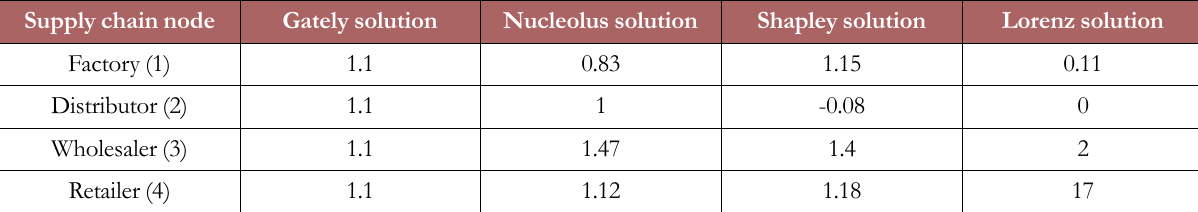
Table 4. Propensity to disrupt of the coalitions various game-theoretic